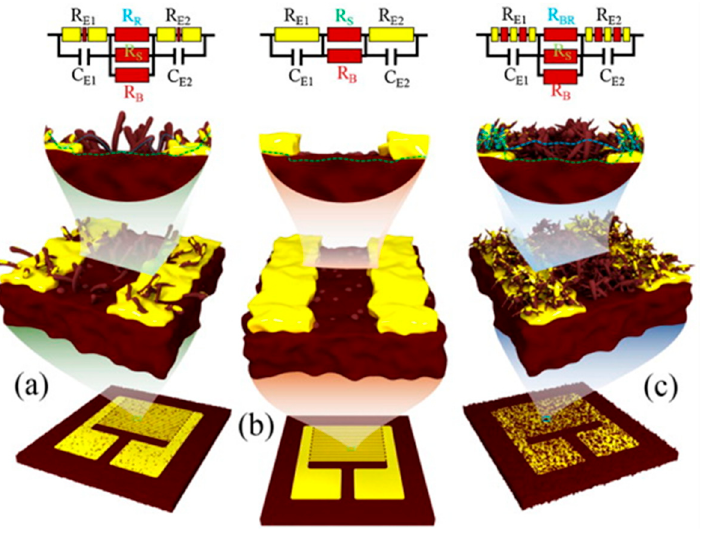
Figure 13. Models and equivalent circuit of the submicron-rod ( a ), thin film ( b ) and submicron-tree ( c ) sensors. It is noted that the total resistance will be reduced if R R and R BR decrease upon exposure to H 2 S. Reproduced from Ref. [116] with permission from Elsevier, 2014.